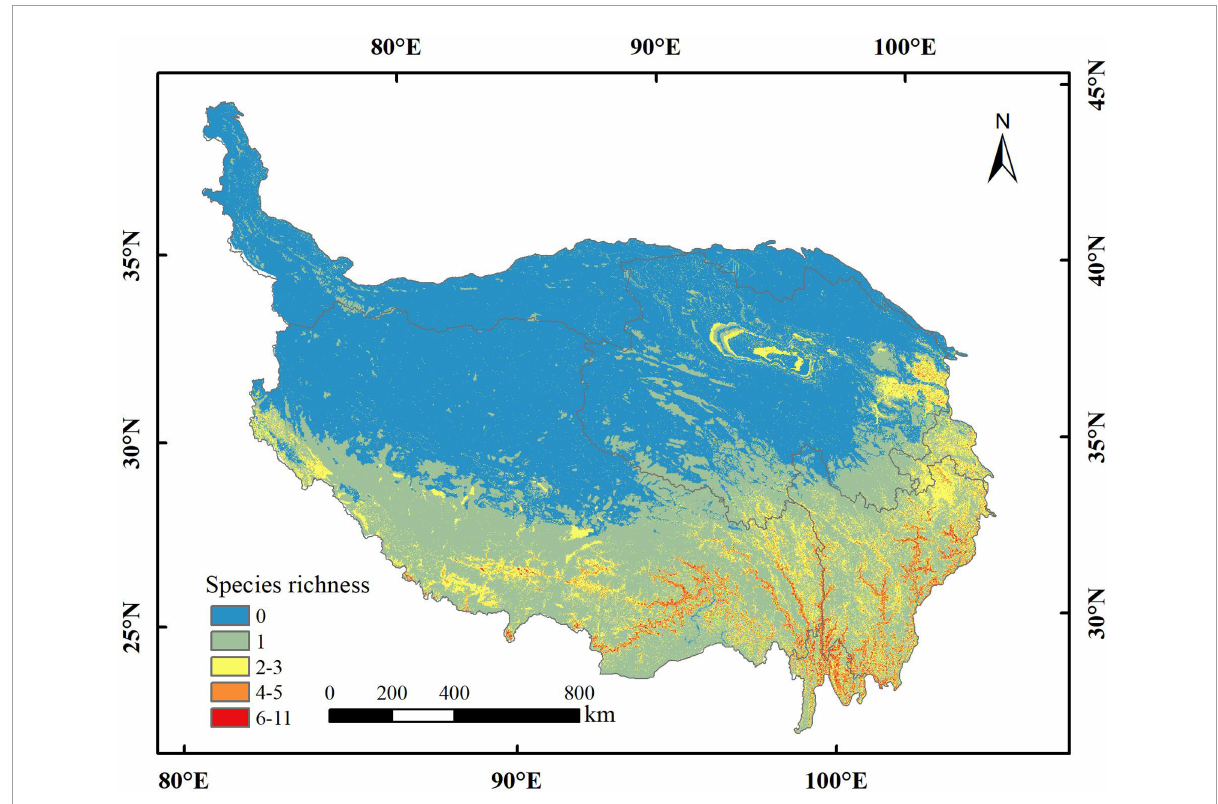
FIGURE3 The current richness distribution of 17 orchid species on the Qinghai-Tibetan Plateau (QTP).